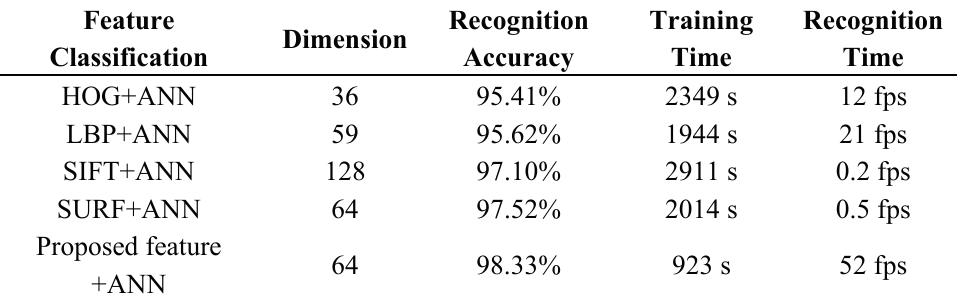
Table 7. Comparison with other works for the STS data